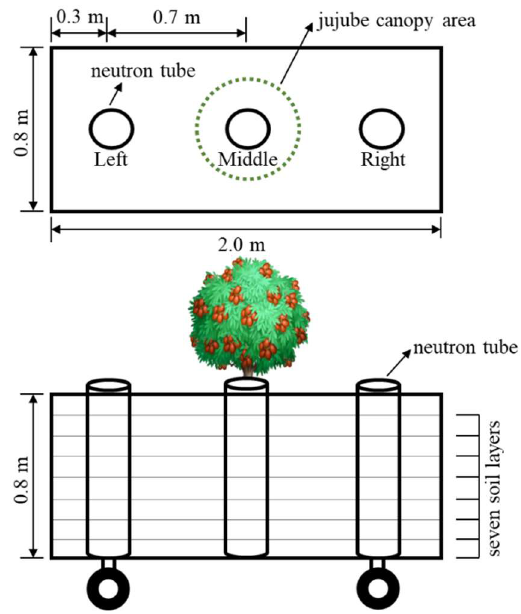
Figure 6. Layout diagram of neutron tubes in experimental plots.